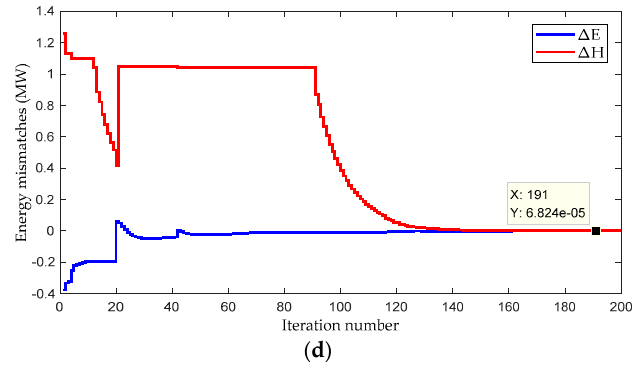
Figure 9. Convergence process of ACA for distributed HEEM. ( a ) Virtual incremental cost; ( b ) energy output or demand; ( c ) no. of searching sub-region of CHP units; ( d ) energy mismatches.